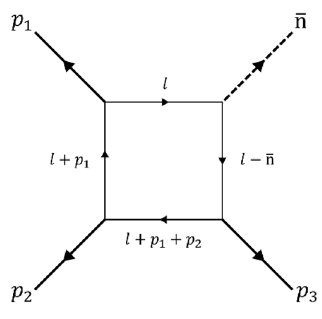
Figure 6. One-loop box with an eikonal